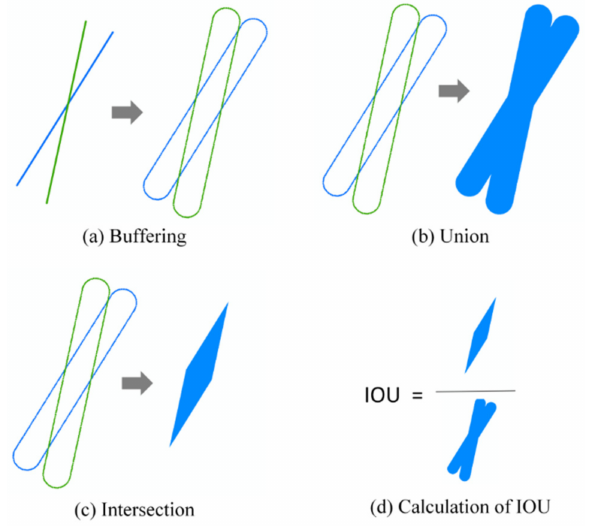
Figure 11. The process of IoU-based similarity measurements between two landslide trails. Illus- tration of ( a ) buffering operation, transforming two trails into two buffered polygons; ( b ) union operation; ( c ) intersection operation; and ( d ) the calculation of